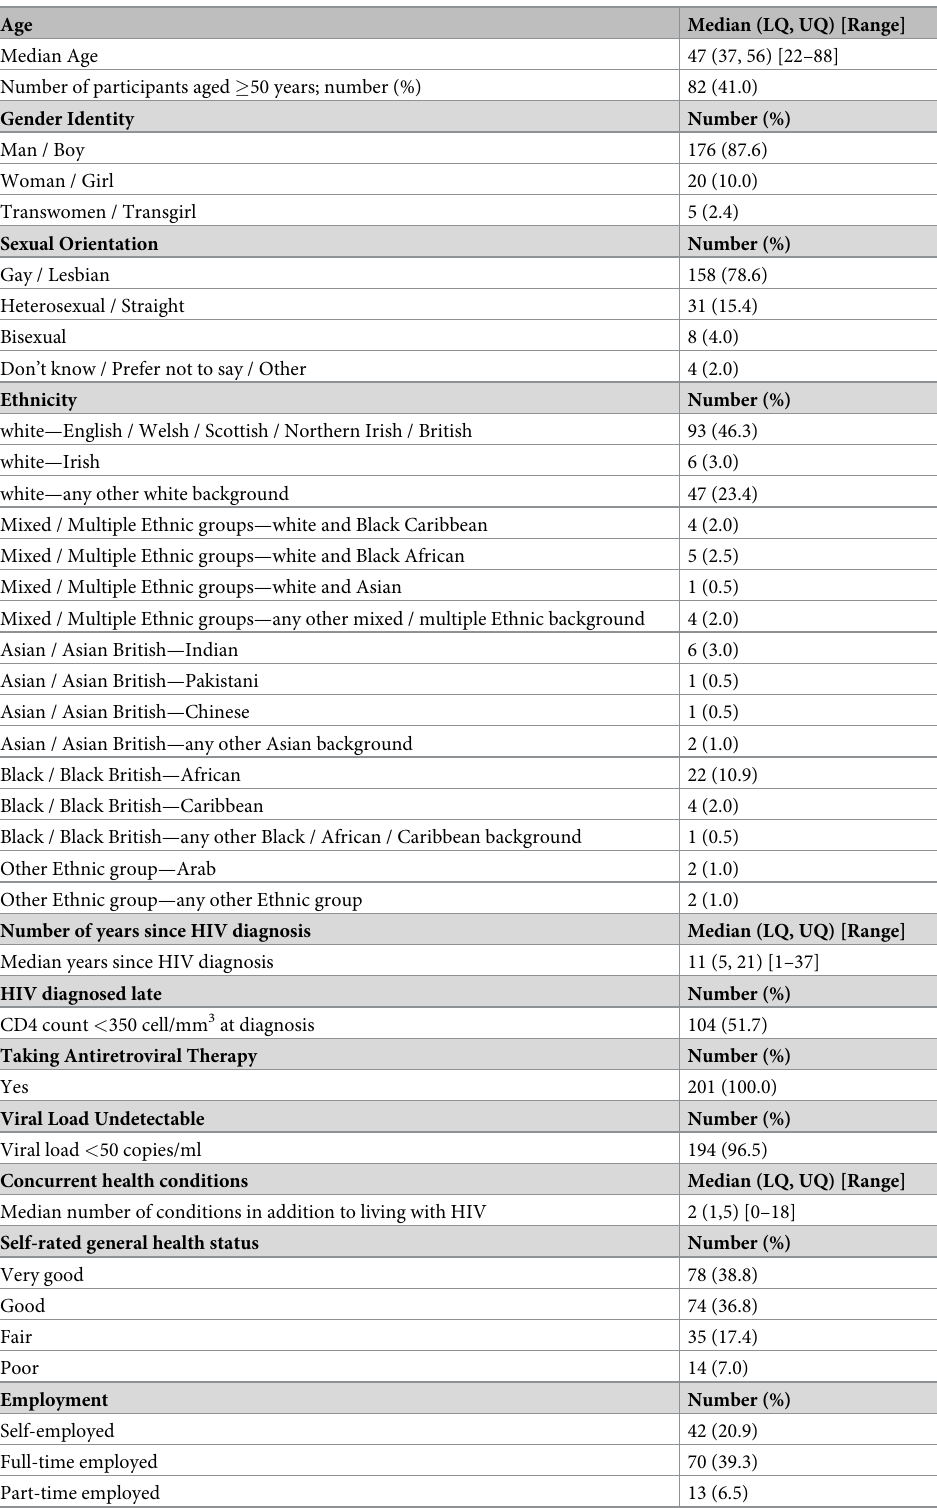
Table 1. Participant